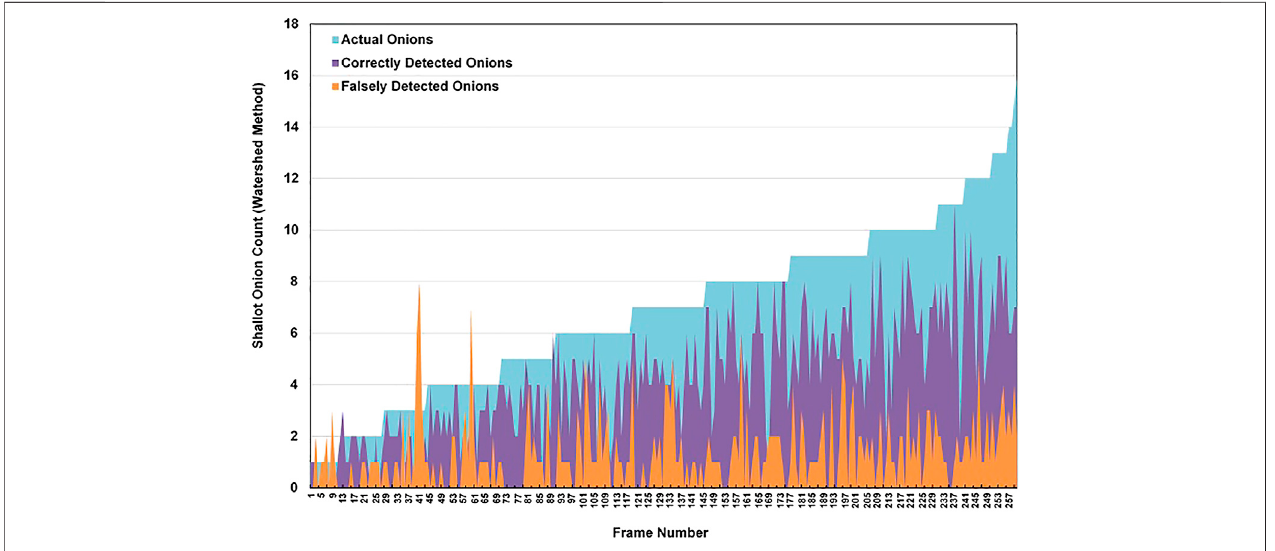
FIGURE 7 | Detection results for the WST